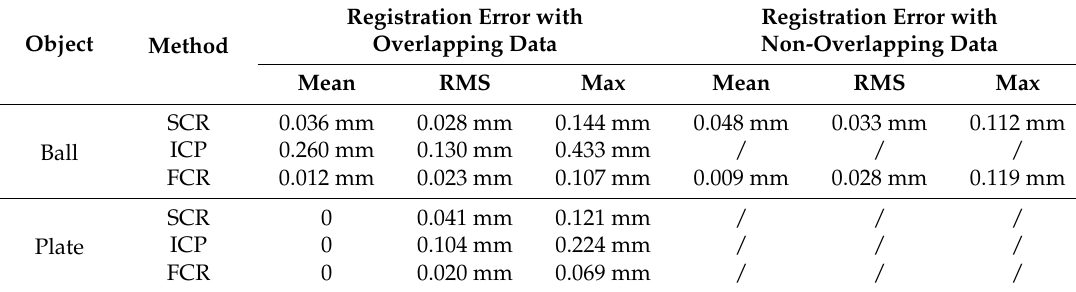
Table 2. Registration results by three registration methods with real experimental